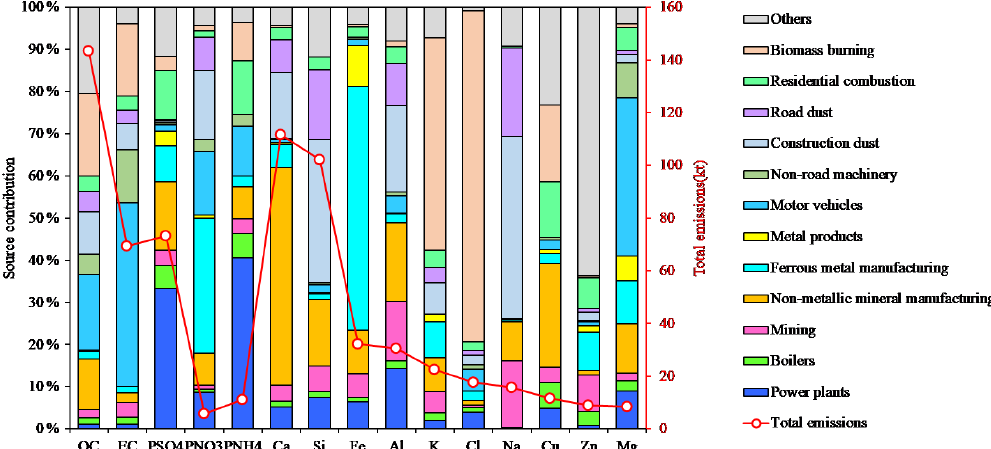
Figure 6. Major source contributions and species comprising PM 2 . 5 in the YRD